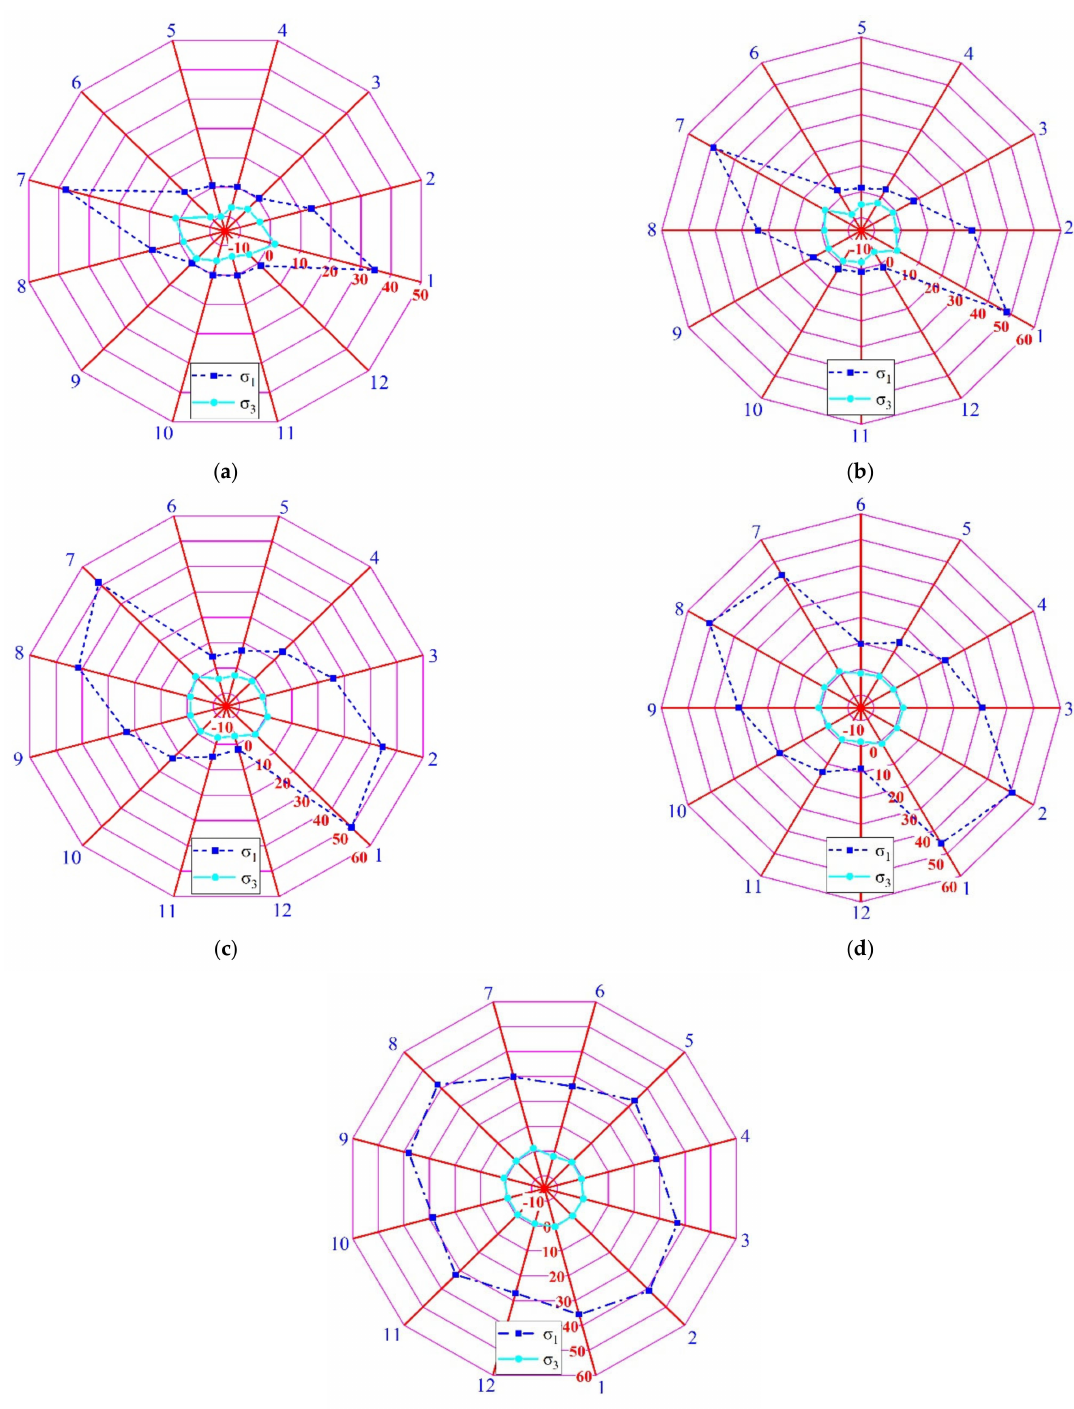
Figure 12. The principal stress distribution around flaw under the crack initiation stress in different models (Unit: MPa). ( a ) β = 15 ◦ ; ( b ) β = 30 ◦ ; ( c ) β = 45 ◦ ; ( d ) β = 60 ◦ ; ( e ) β = 75 ◦